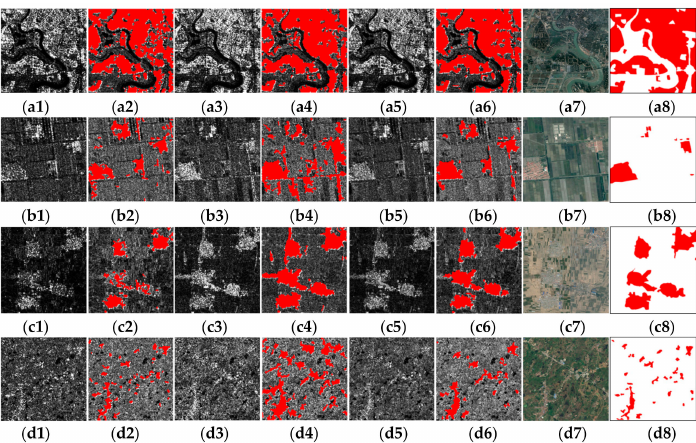
Figure 2. BAs extraction in different environments. The first row to the fourth row show the high-density housing area ( a1 – a8 ), agricultural field area ( b1 – b8 ), rural housing area in northern China ( c1 – c8 ), and rural residential area in southern China ( d1 – d8 ), respectively. The first column to the eighth column show the VV images ( a1 – d1 ), BAs of VV images ( a2 – d2 ), VH images ( a3 – d3 ), BAs of VH images ( a4 – d4 ), averaged images of VV and VH ( a5 – d5 ), BAs of averaged images ( a6 – d6 ), the corresponding optical images from Google Earth map ( a7 – d7 ), and the ground truth maps ( a8 – d8 ), respectively. Red: